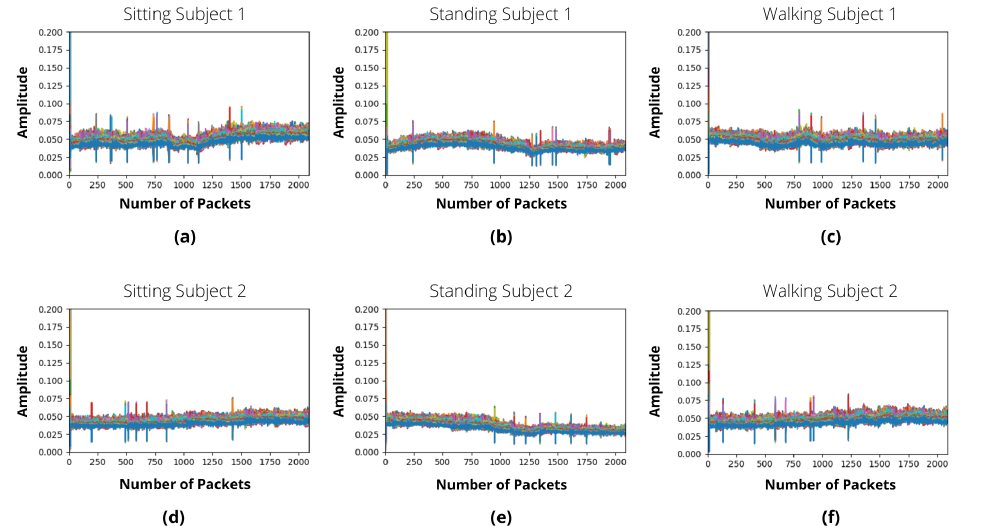
Figure 5. IRS-ON activities samples in form of CSI in a multi-floor scenario. ( a ) Person 1 sitting. ( b ) Person 1 standing. ( c ) Person 1 walking. ( d ) Person 2 sitting. ( e ) Person 2 standing. ( f ) Person 2 walking.